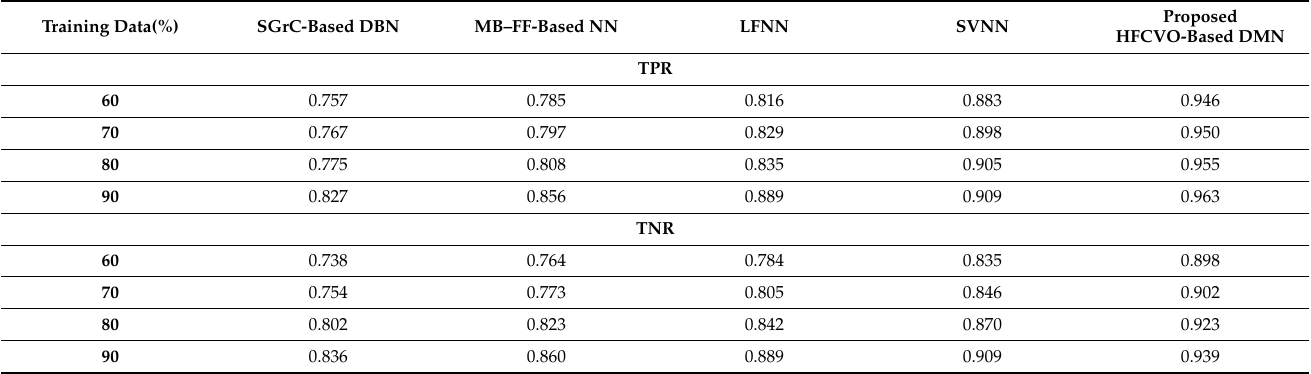
Table 6. Comparative analysis using 20-Newsgroup Dataset for TPR, TNR, FNR, Precision, and testing